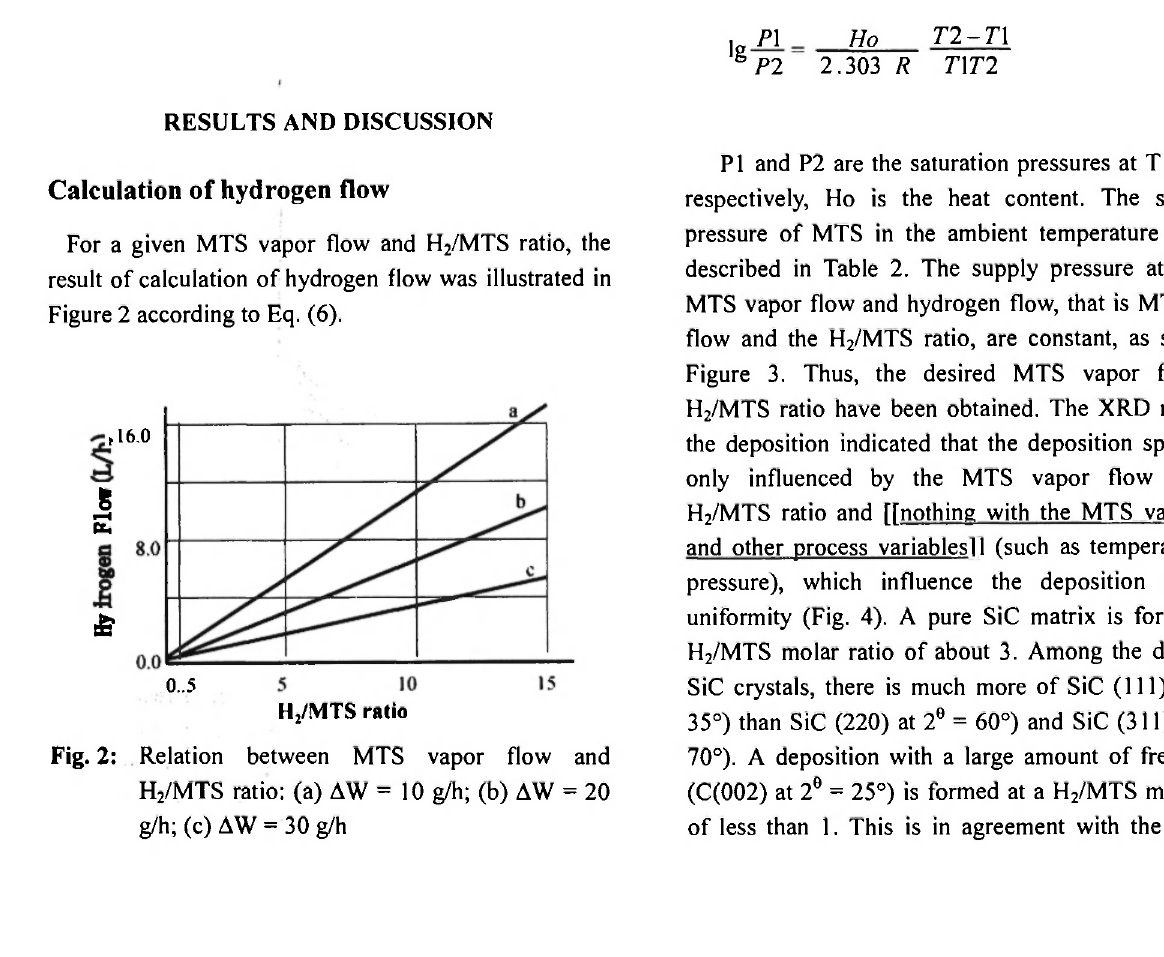
PI and P2 are the saturation pressures at T1 and T2 respectively, Ho is the heat content. The saturation pressure of MTS in the ambient temperature range is described in Table 2. The supply pressure at a given MTS vapor flow and hydrogen flow, that is MTS vapor flow and the H 2 /MTS ratio, are constant, as shown in Figure 3. Thus, the desired MTS vapor flow and H 2 /MTS ratio have been obtained. The XRD results